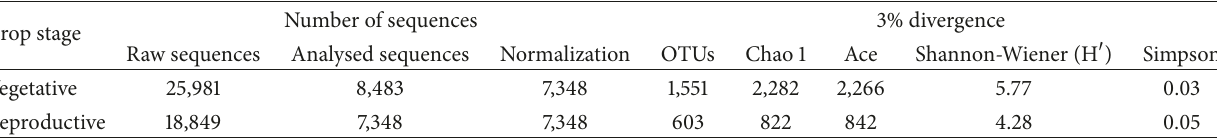
Table 2: Richness estimators (Chao 1 and Ace) and diversity indices of Shannon-Wiener (H 󸀠 ) and Simpson from bacterial communities sampled from floodwaters during reproductive and vegetative stages of rice using 16S amplicons. A 3% nucleotide dissimilarity was used for OTU discrimination.